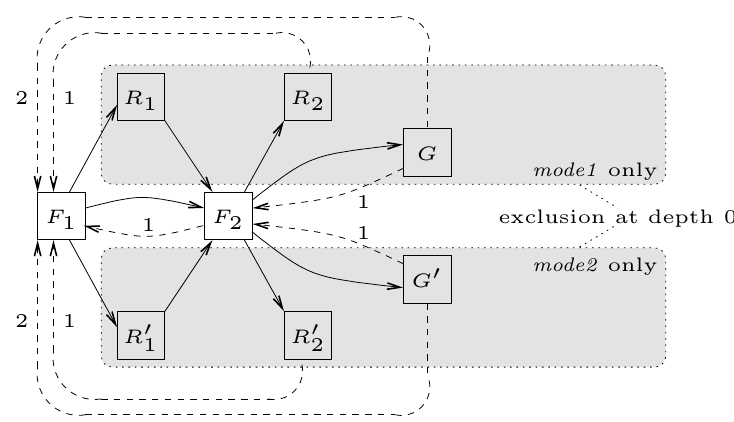
Figure 3 Example of dependent task system.